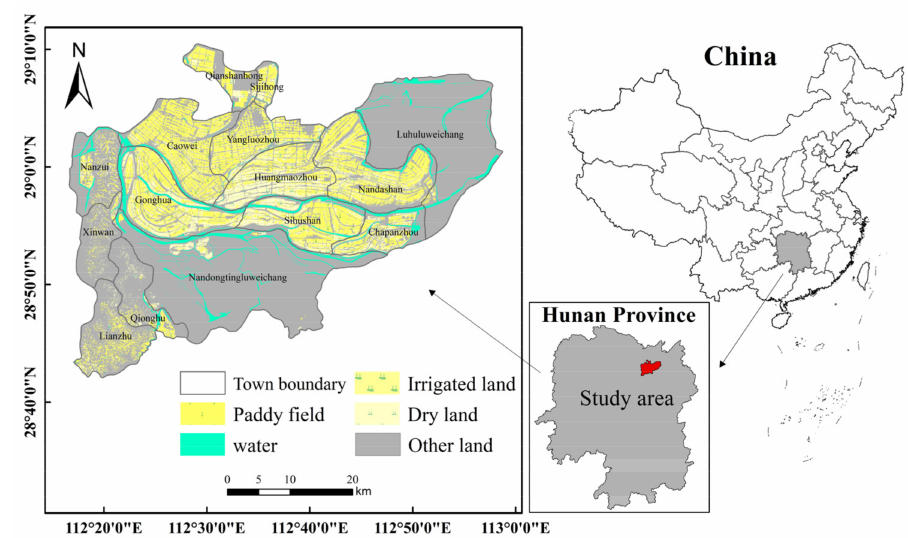
Figure 1. Location of the study area and land use of Yuanjiang county in 2018.